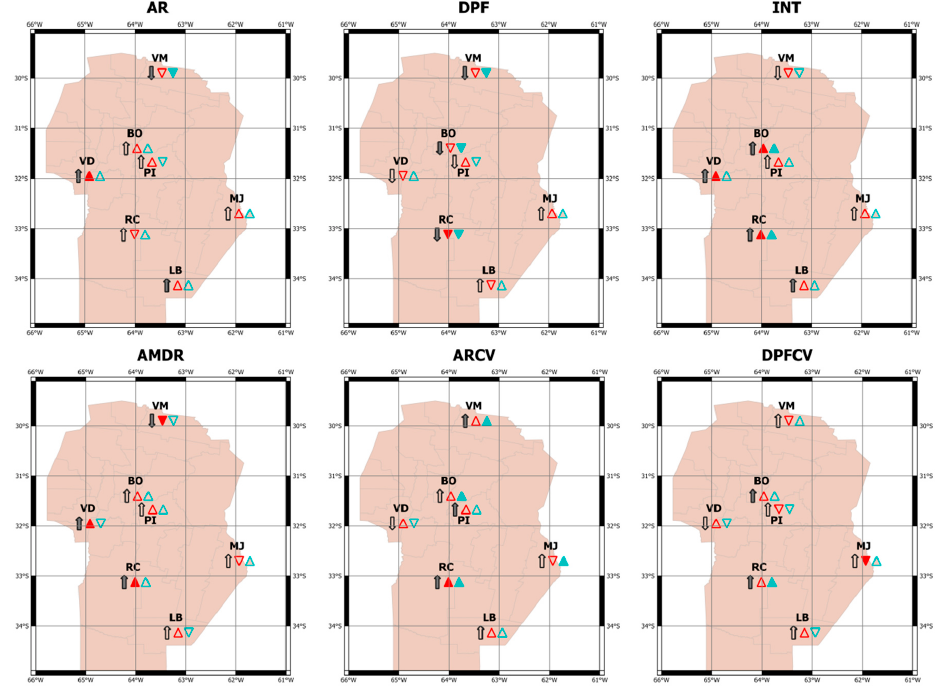
Figure 3. Mann–Kendall (MK) test (Z) to detect trend for annual (arrow), warm season (WS) (red triangle) and cold season (CS) (green triangle) rainfall time series of total annual rainfall (AR), annual frequency of rainy days (DPF), mean intensity (INT), maximum daily value (AMDR), and the coefficients of variation of AR (ARCV) and DPF (DPFCV), at different weather stations at Córdoba, Argentina. When symbols are upward (down), this indicates a positive (negative) trend, while filled symbols indicate statistical significance ( p < 0.10).